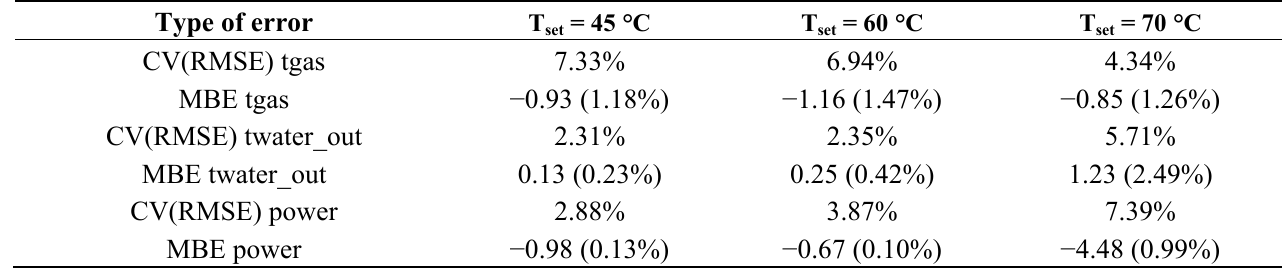
Table 2. Values of CV(RMSE) and MBE for T temperatures. T set